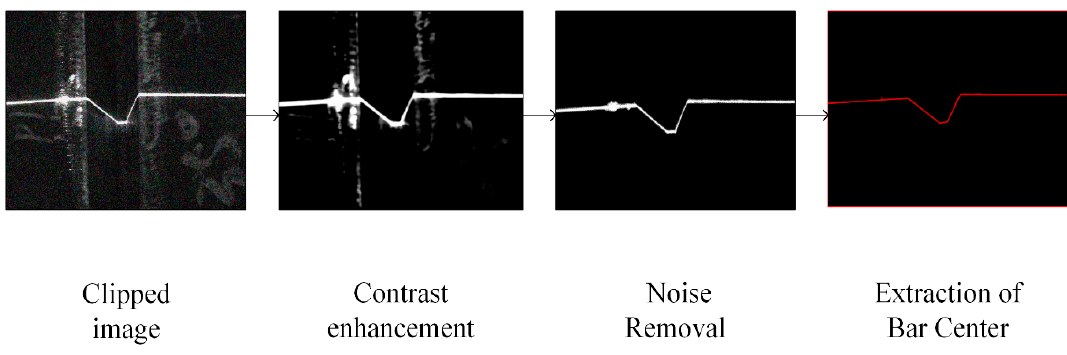
Figure 18. Image Figure 18. Image processing. Figure 18. Image processing.